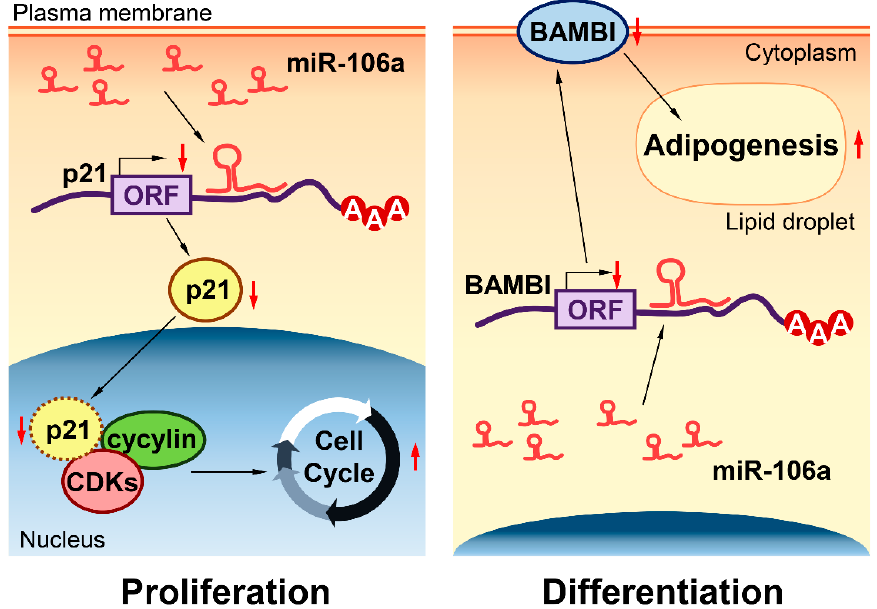
Figure 6. A schematic diagram of miR-106a regulation on porcine preadipocyte proliferation and differentiation. In proliferating cells (left), miR-106a can promote porcine preadipocyte proliferation by targeting p21 . In differentiating cells (right), miR-106a can promote adipogenic differentiation by targeting BAMBI in porcine tissue. The red upward arrow means that this process is promoted; the red downward arrow means that this process is inhibited.